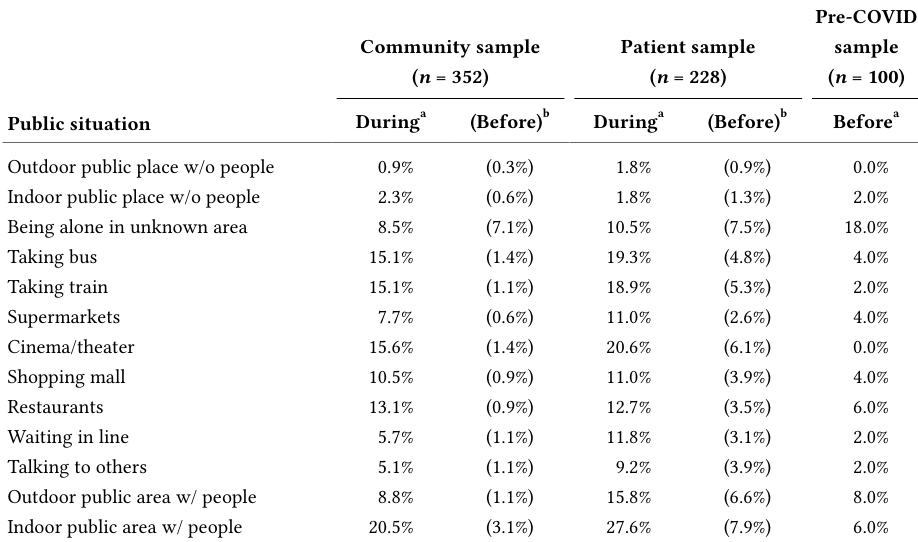
Relative Frequency of High or Very High Anxiety to Distinct Public Situations